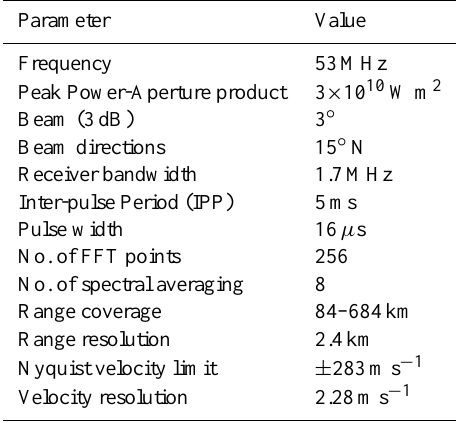
Table 1. Radar parameters used for studying the F-region irregular-